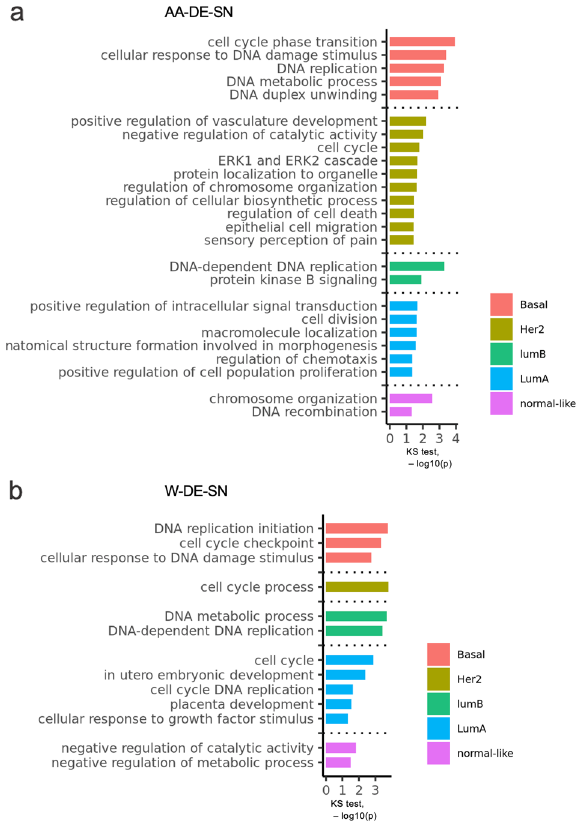
Fig. 5 GO enrichment analysis of DE-SN. Bar plots depicting the signi fi cantly, p -value < 0.05, enriched GO terms of the DE-SN in PAM50 subtypes from either AA patients only ( a ) or from W patients only ( b ). The x -axis in a and b depicts the – log10 p -value yielded from the Kolmogorov – Smirnov test. The enriched GO terms are included next to the